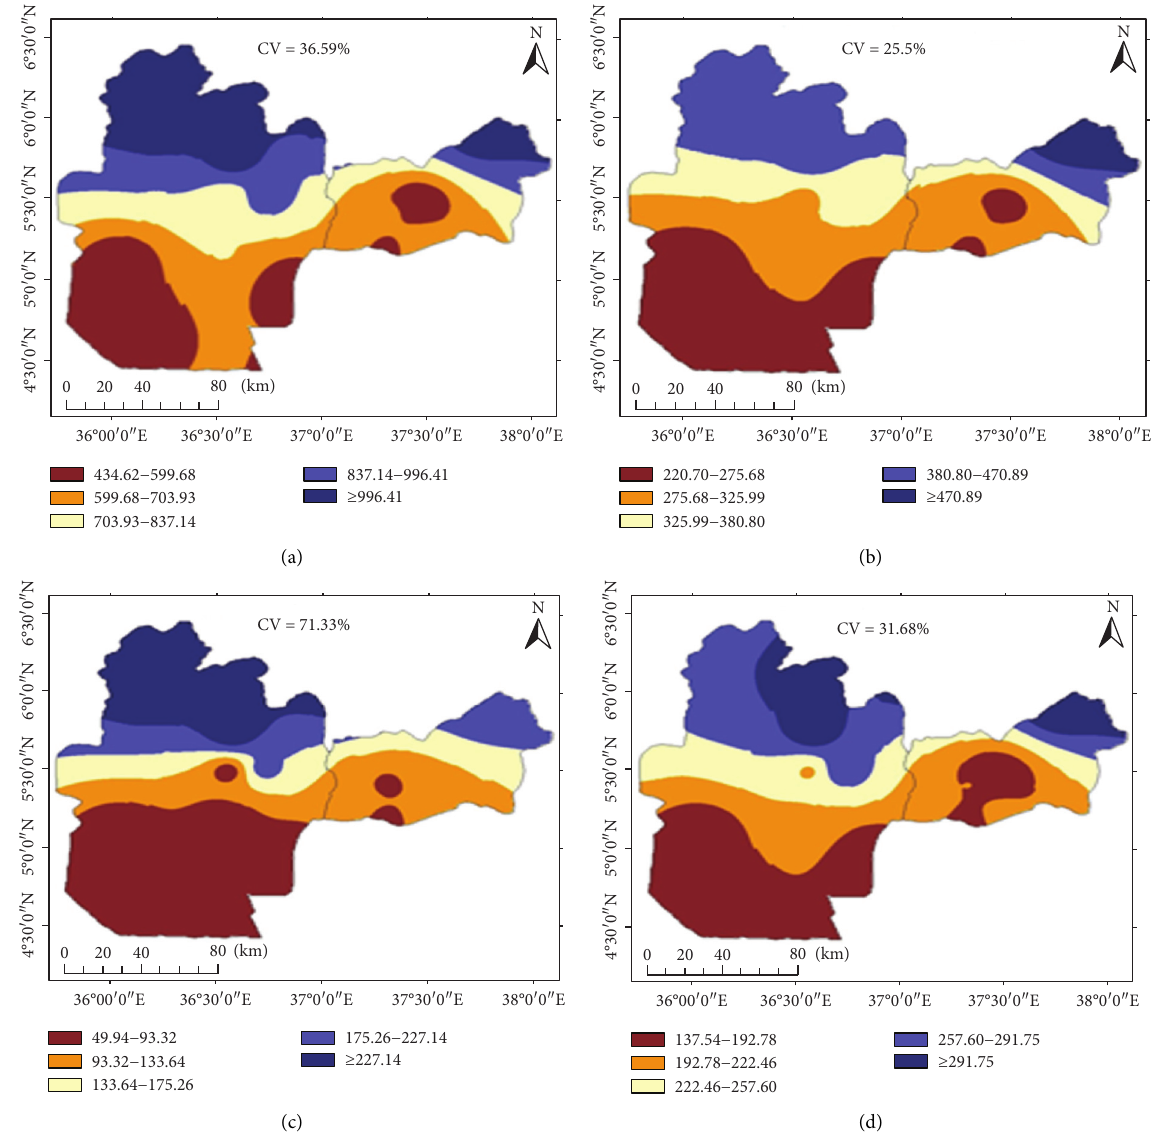
Figure 3: Spatial distribution and variability of mean annual and seasonal rainfall of Southwest Ethiopia (1983–2016). (a) Annual rainfall, (b) Spring ( Belge ) rainfall, (c) Summer (Kiremt) rainfall, and (d) Autumn